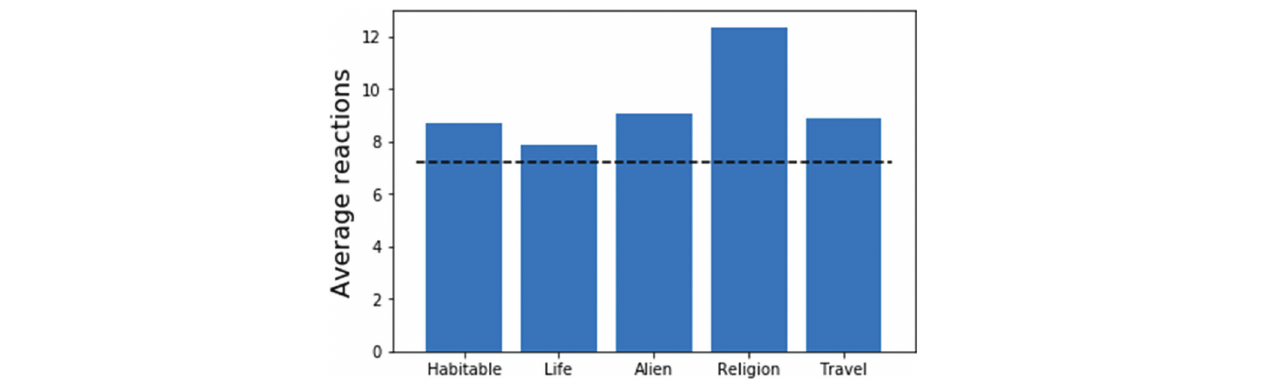
Figure 5. Average number of reactions for news comments containing certain keywords; the dashed line denotes the average for all comments in the selected articles (Source: Authors,